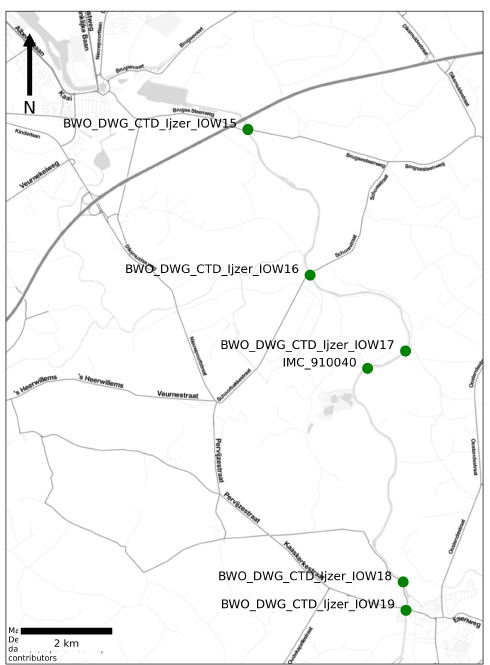
Figure 13. Stations on the Yser river between the cities of Diksmuide and